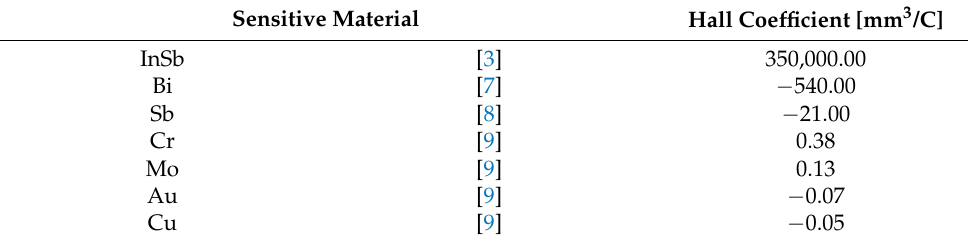
Table 1. Hall coefficients at room